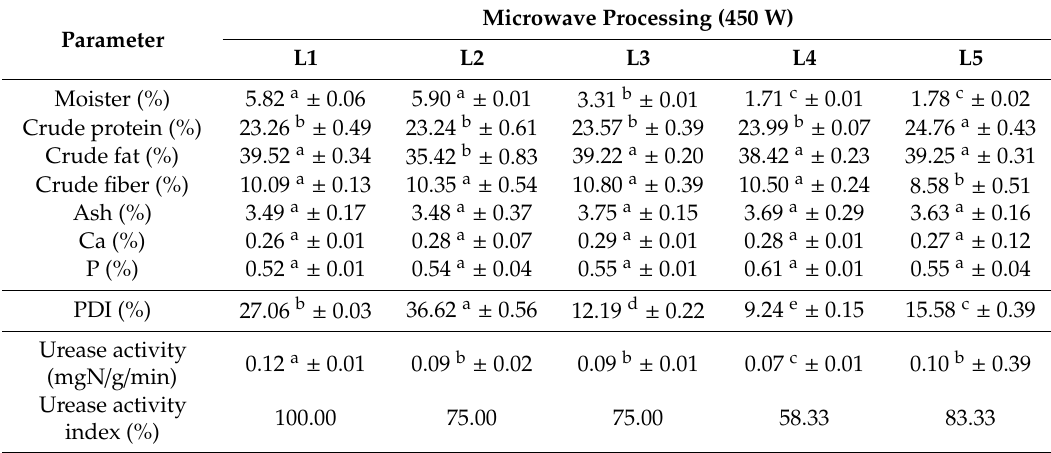
Table 2. Nutritive value, crude protein solubility and urease activity levels of